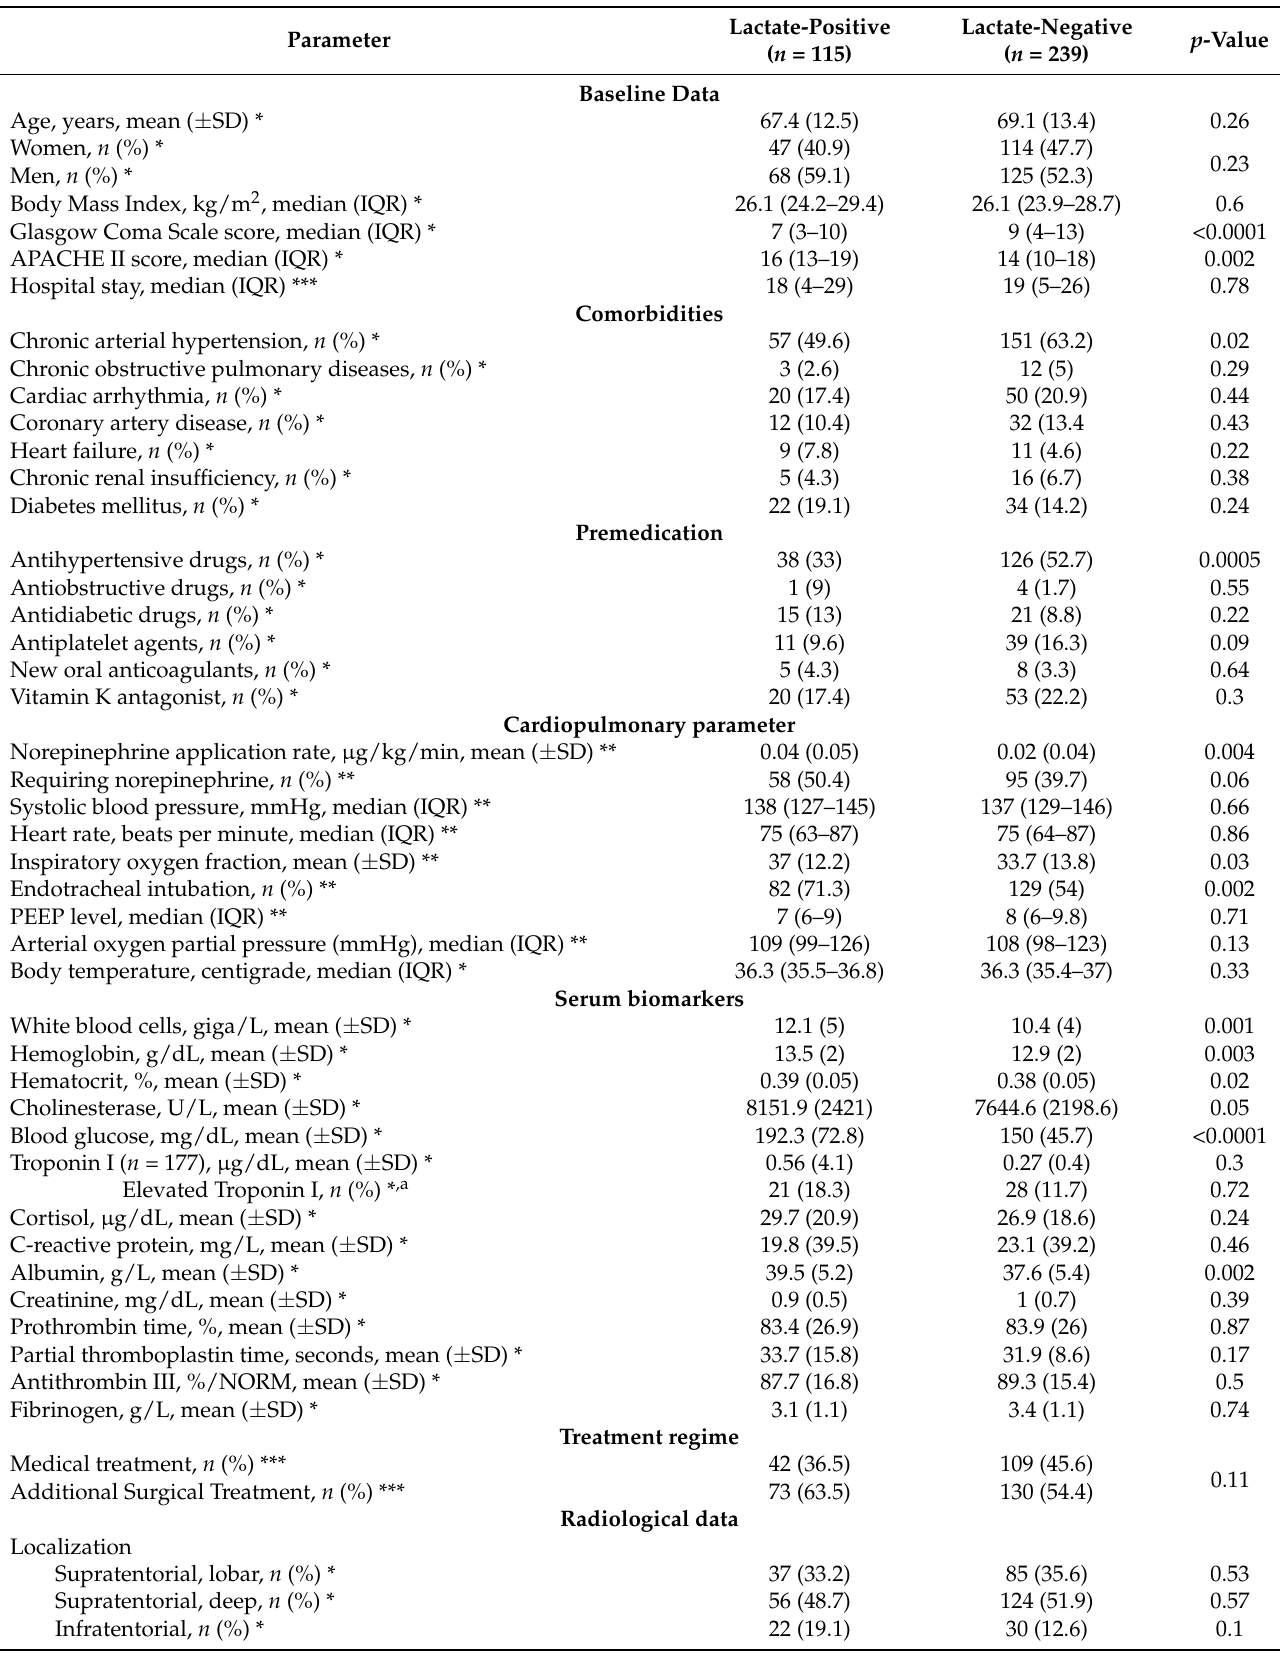
Table 2. Univariate analysis of the serum lactate